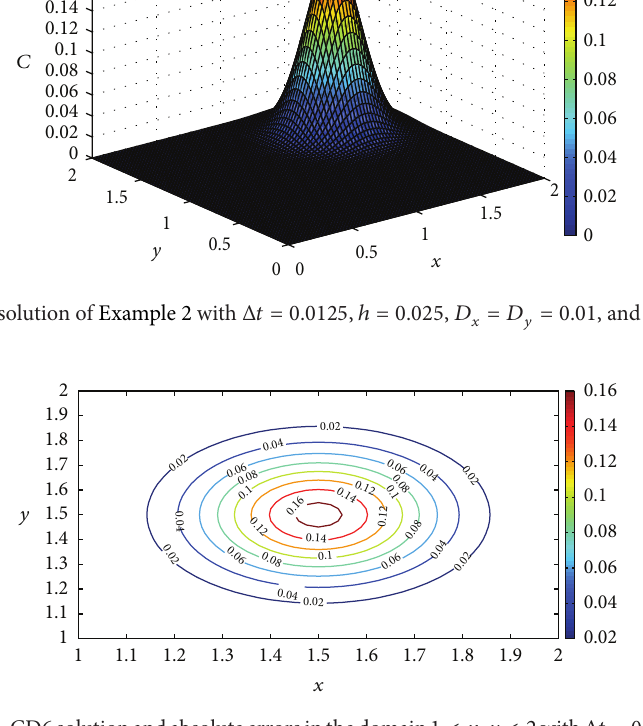
Figure5:ContourlinesoftheRK4-CD6solutionandabsoluteerrorsinthedomain 1 < 𝑥 , 𝑦 < 2 with Δ𝑡 = 0.0125 , ℎ = 0.025 , 𝐷 𝑥 = 𝐷 𝑦 = 0.01 , and 𝑡 = 1.25 .